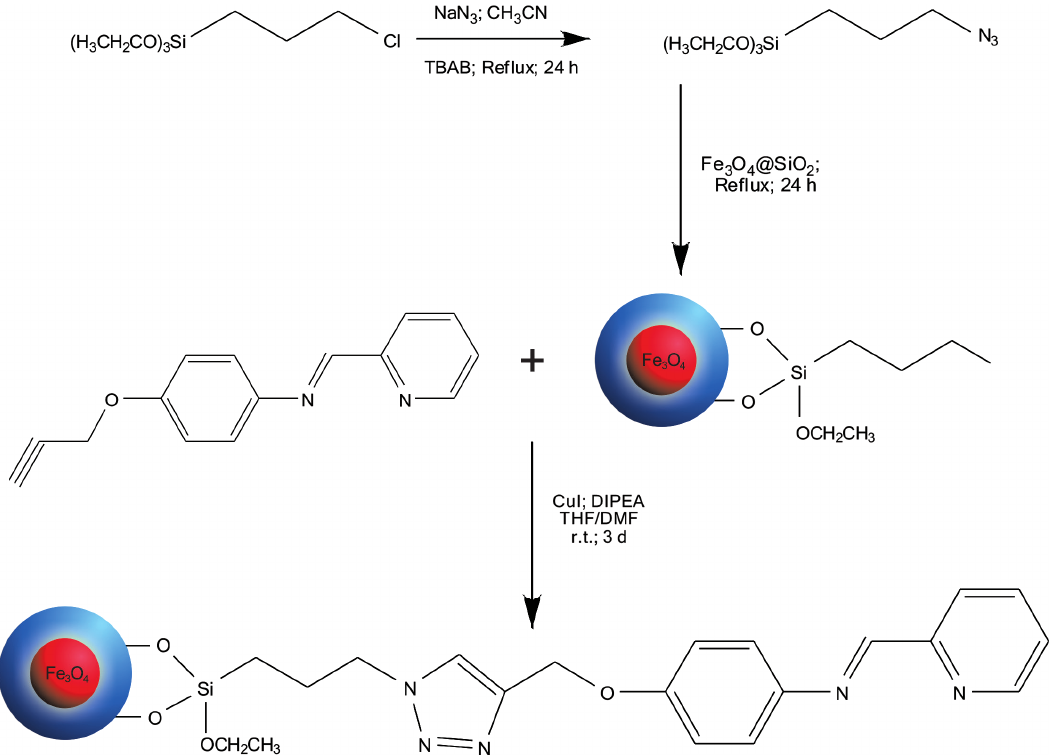
Figure 12 Core-shell silica-coated magnetite functionalized with iminopyridine by the “click” chemistry